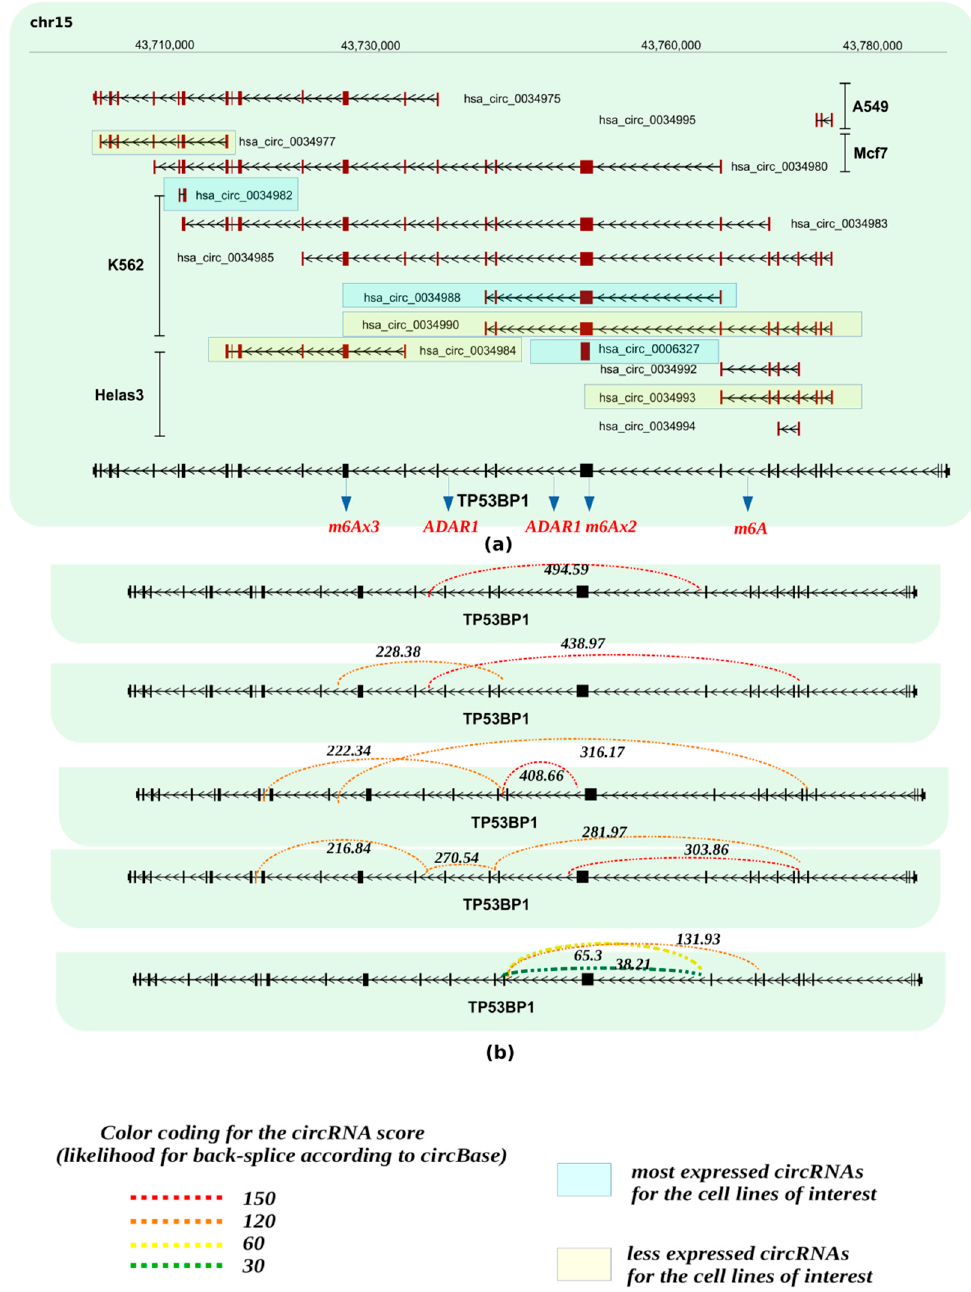
Figure 3. Potential circRNAs derived from the TB53BP1 gene locus. ( a ) Predicted circRNAs at the TB53BP1 gene locus, based on NGS data, as deposited at circBase and CIRCpedia are shown over the corresponding loci, based on human genome GRCh37/hg19. Cell lines in which NGS was performed to obtain the depicted circRNAs are also shown and were retrieved from circBase. ( b ) The expression values for the estimated circRNAs were derived from the junction reads, the form of circBase and CIRCpedia from Ribo zero RNA-seq. The strength of the back-splicing event is demonstrated using a dashed line, where different scores are shown for the expressed back-spliced events. Furthermore, we indicate from miCLiP experiments [91] a consensus of m6A sites and editing sites as derived from RNA editing events using the Jacussa pipeline [92] as well as from ADAR1 CliP binding sites.